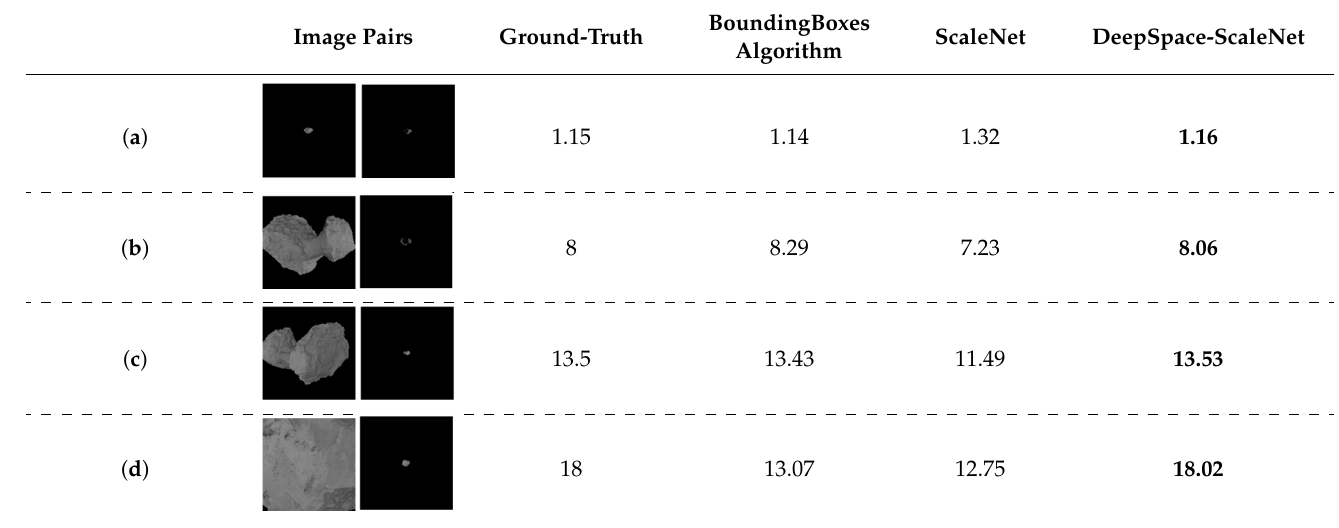
Table 3. Qualitative results of scale estimation of the above-mentioned state-of-the-art methods. Image Pairs